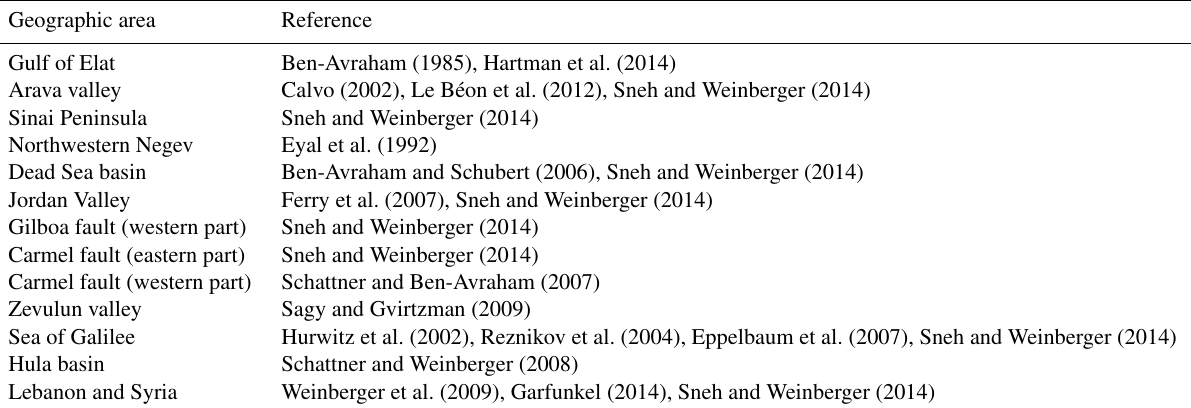
Table A3. References for faults located beyond Israeli borders and/or subsurface faults. Geographic